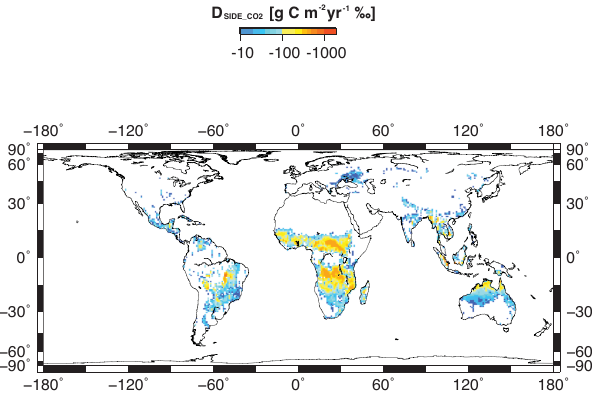
Figure 6. Relationship of isotopic disequilibrium values (SIDE = δ 13 C flux – δ 13 C pool ) to the initial proportion of grass biomass (percentage by mass). Error bars of percentage grass biomass represent the range of values measured from two 1m 2 quadrats. Error bars of (cid:49)δ 13 C represent values calculated using the difference from the isotopic composition of standing biomass ( δ 13 C pool ) as determined by one of two methods: (1) measurement of the bulk C isotopic composition of biomass collected from the two quadrats and (2) estimated carbon isotopic composition based on the mass of woody and grass biomass, assuming specific values for C 3 woody biomass ( − 27.2‰) and for C 4 grass biomass ( − 13.1‰; values from Cerling et al., 1997). Solid line shows best curve fit of the power-law equation, with dashed lines representing 90% confidence intervals. n = 16 for proximal components; n = 15 for distal components. Residuals of the power law fits to the distal HyPyC and distal PyC data showed a normal distribution (Jarque–Bera), with mean residual SIDE values of − 0.03 and − 0.02‰, respectively.